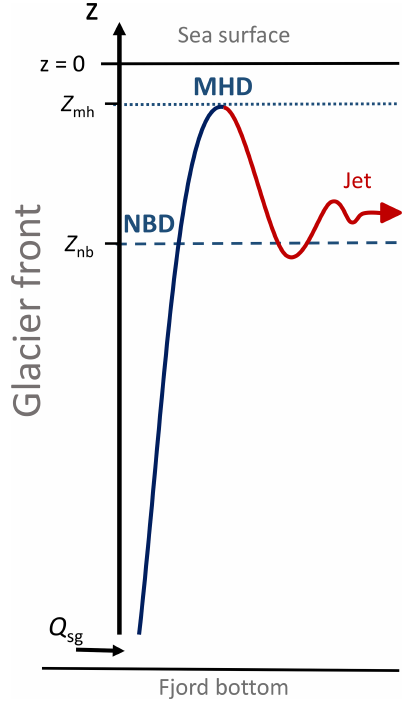
Figure 3. Schematic of plume characteristic heights, i.e., neutral buoyancy depth (NBD) and maximum height depth (MHD), and the associated jet pathway. Note that the plume model does not rep- resent plume dynamics after the maximum height is reached (red line), but it is expected that the jet will sink to a depth similar to the